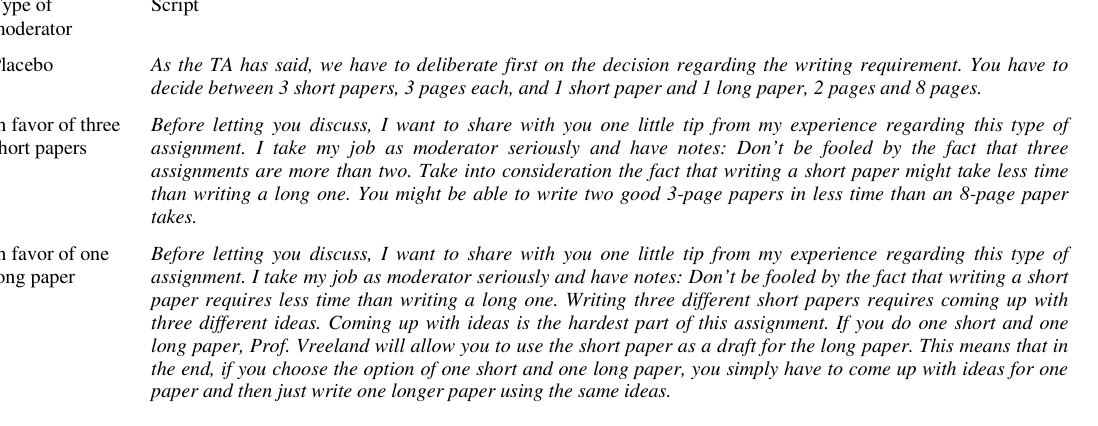
Table A2: First discussion, opening intervention